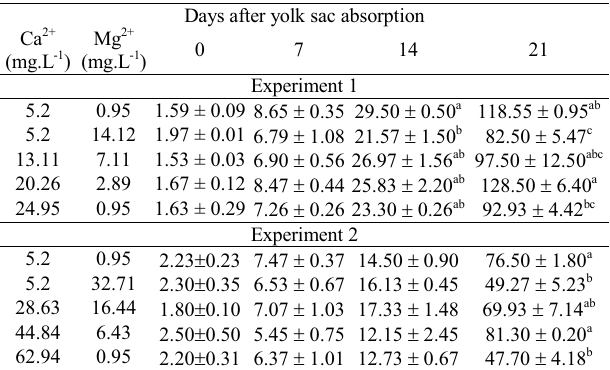
Table 4. Weight (mg) of silver catfish larvae as a function of Ca 2+ and Mg 2+ concentrations in the water. Means (±SEM) with different letters in the same column and experiment are significantly different (P < 0.05) as determined by ANOVA and by the Tukey test. First line of each experiment is the . treatment with water hardness of 20 mg.L -1 CaCO 3